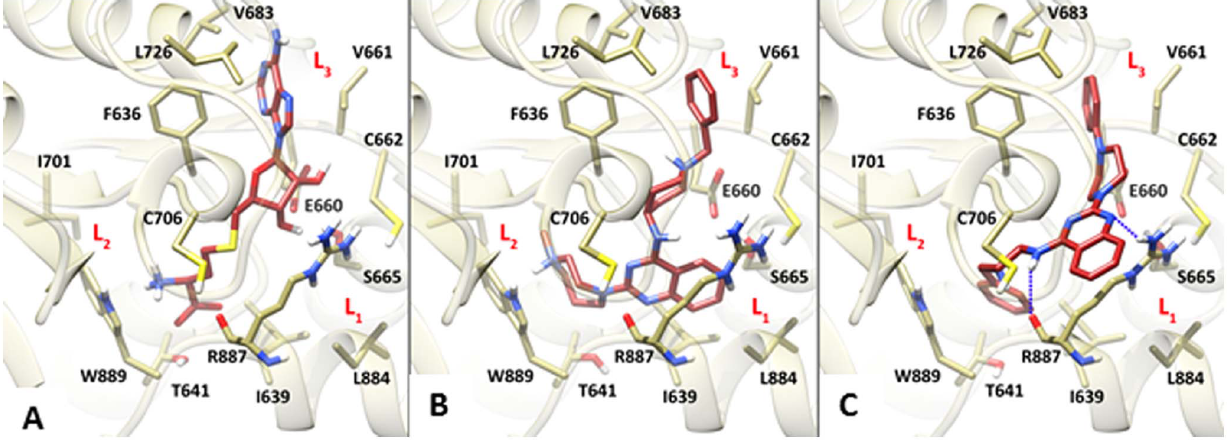
Figure 4. Docking studies of 4 and 14 into the DNMT3A active site. Experimental (A) and theoretical (B and C) binding mode of AdoHcy (A), 4 (B) and 14 (C) in the DNMT3A active site. Protein is depicted as light yellow ribbons and sticks while ligands are depicted as red sticks. Hydrogen- bonds are depicted as dashed blue lines.